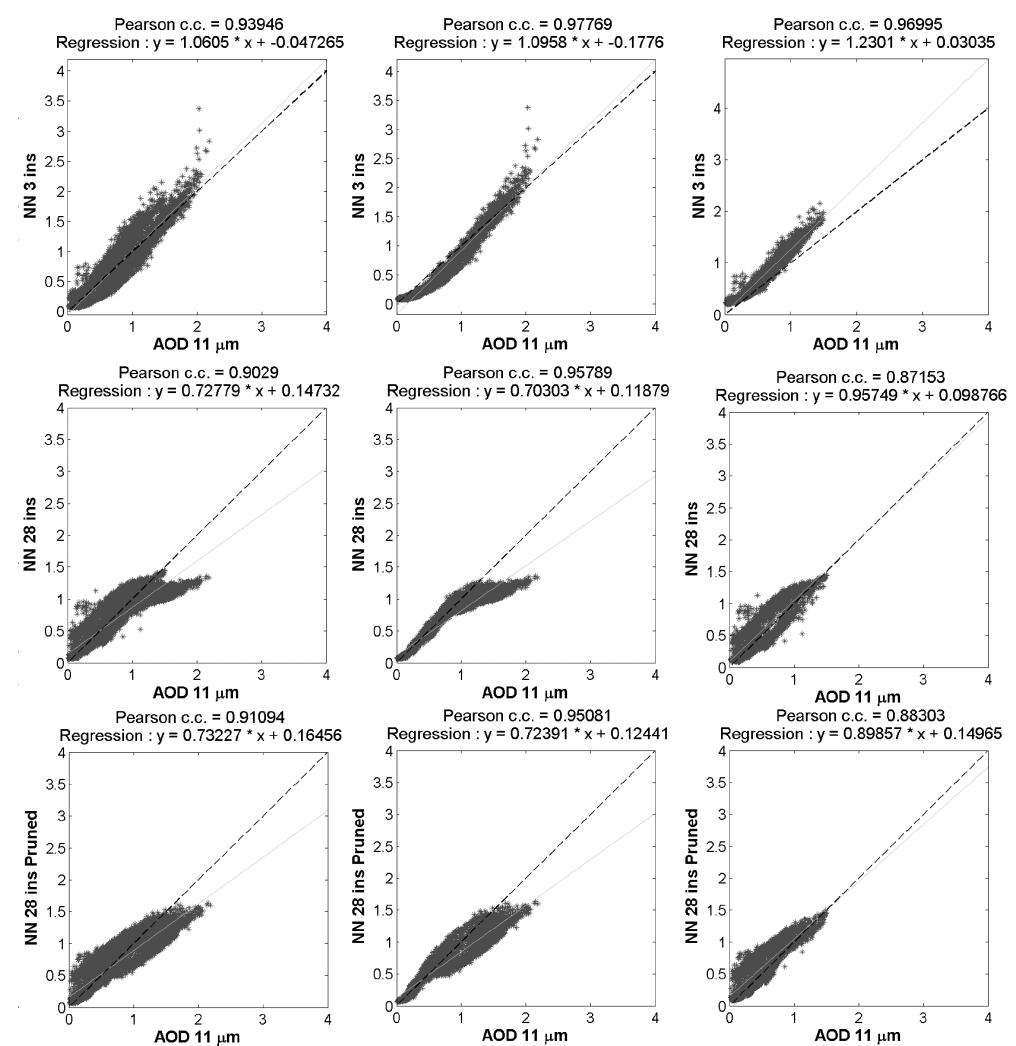
Figure 12. Scatterplots for AOD networks, 3 inputs (top row), 28 inputs (middle row) and 28 inputs pruned (bottom row), applied to the validation set of 12 May 2010, 12:55UTC, divided into total patterns (left column), patterns over sea (middle column) and patterns over meteorological clouds (right